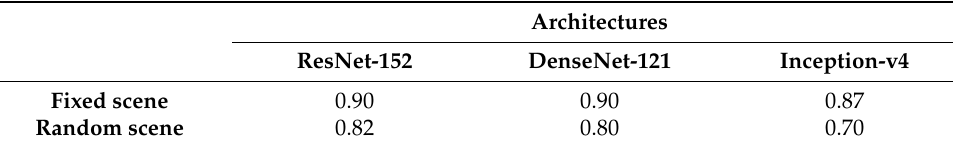
Table 6. Results of scene change on the Cerema-AWH database with 5 meteorological class